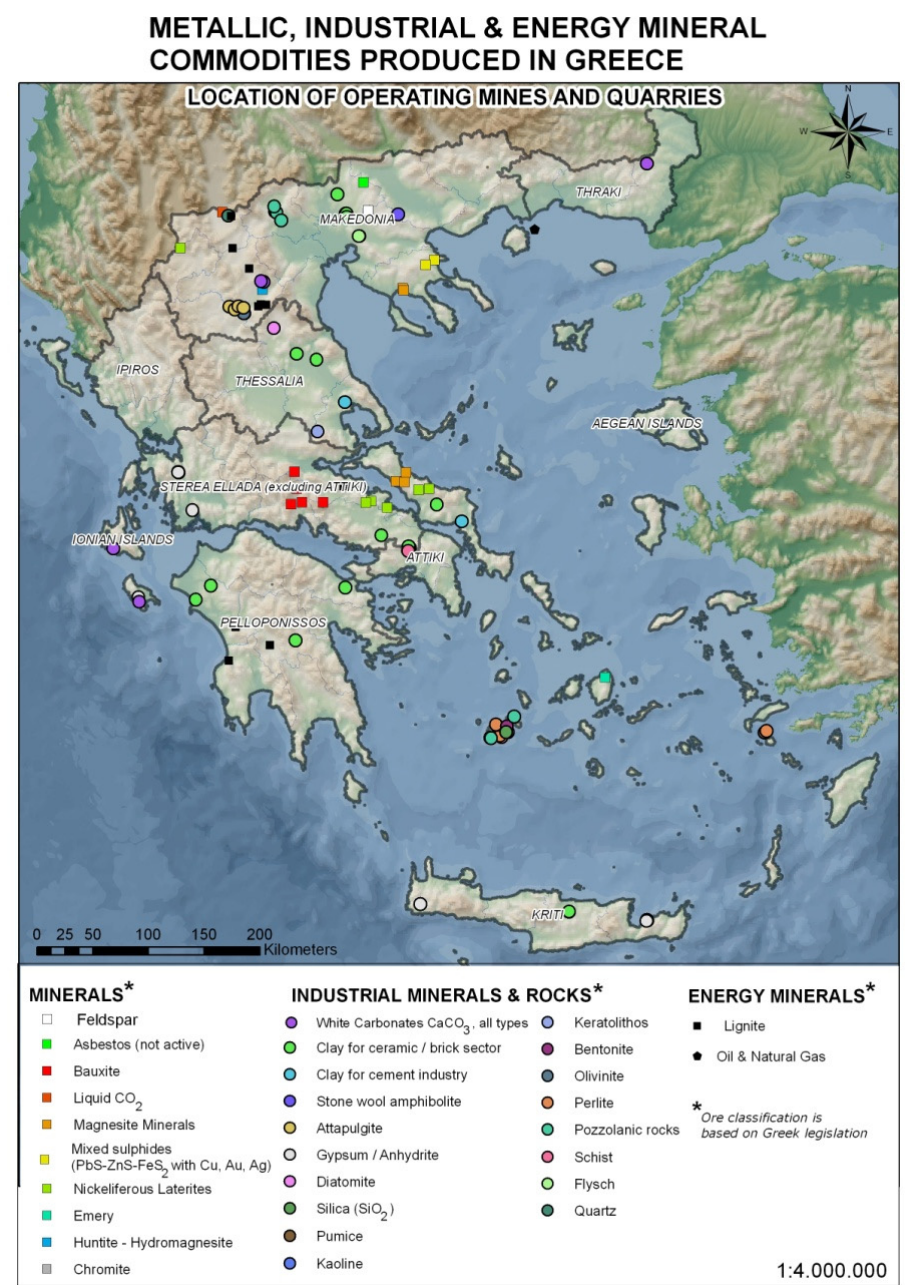
Figure 1. Metallic, Industrial and Energy Mineral Commodities produced in Greece